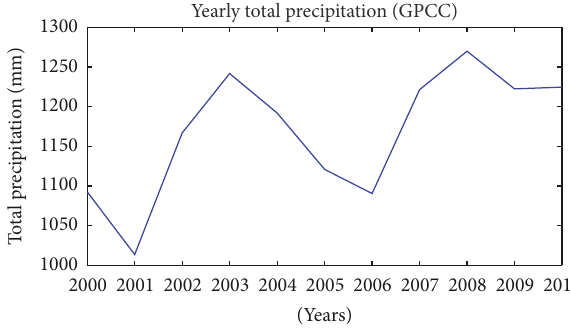
Figure 1: Yearly total area mean observed (GPCC) precipitation time series for 11 years for